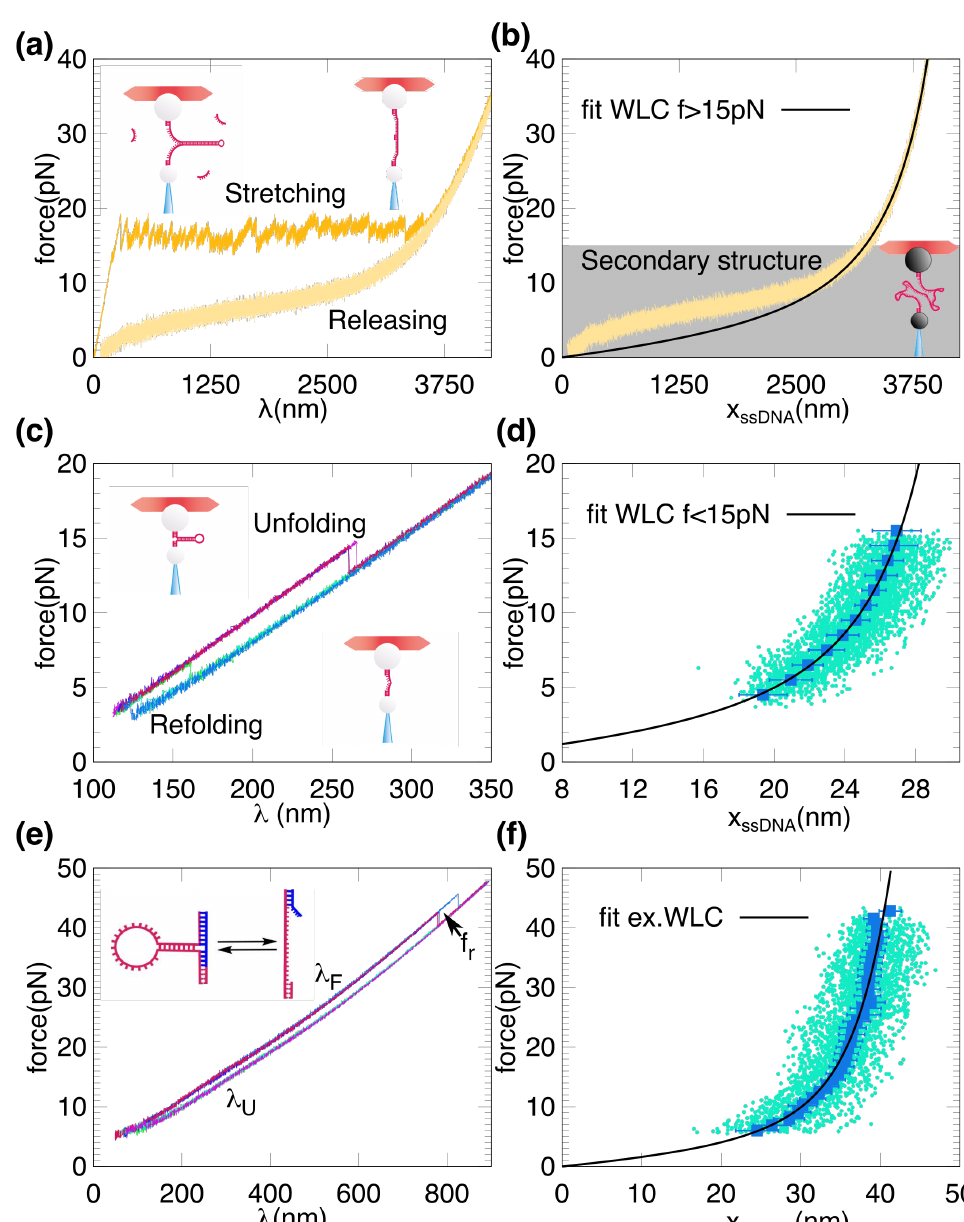
Figure 2. FDCs and FECs for long and short DNA hairpins. ( a ) Stretching (upper sawtooth pattern) and releasing (lower smooth pattern) FDC for a LH (H3594). ssDNA is obtained during the releasing process from long molecules by using the BLO method described in [25]. ( b ) Representative FEC for H3594. The gray area indicates the force range at which the secondary structure is formed and hence the fit using Equation (7) (black curve) is done only for high forces ( f > 15 pN). ( c ) Unfolding (upper branch of the FDC) and refolding (lower branch of the FDC) for the SH. ( d ) Representative points of a FEC obtained for the SH. The blue squares are the averaged FEC obtained from 100 unfolding and refolding trajectories (cyan dots), using Equation (4). The black curve is the fit of the inextensible WLC model (Equation (7)) to the averaged data. ( e ) Same as in ( c ) but using the BSO method, with an overhang complementary to the second handle of 15 bases (blue oligo in the schematic depiction). ( f ) Same results as in ( d ) but obtained using the BSO method (Equation (5)). FEC data cover a larger force range as compared to ( d ). The black curve is a fit of the extensible WLC model of (Equation (8)) to the averaged